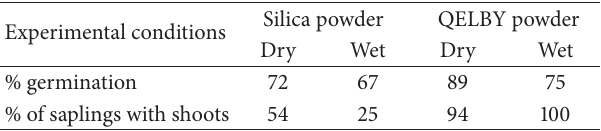
Table 2: Percentage seed germination and percentage of saplings with shoot growth in chickpea seeds surrounded by wet/dry powder during a one-week growth period ( n :